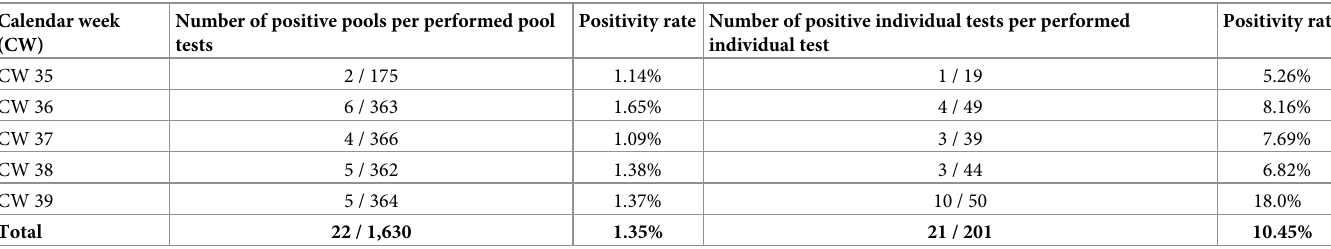
Table 1. Number and results of pool and individual tests per calendar week